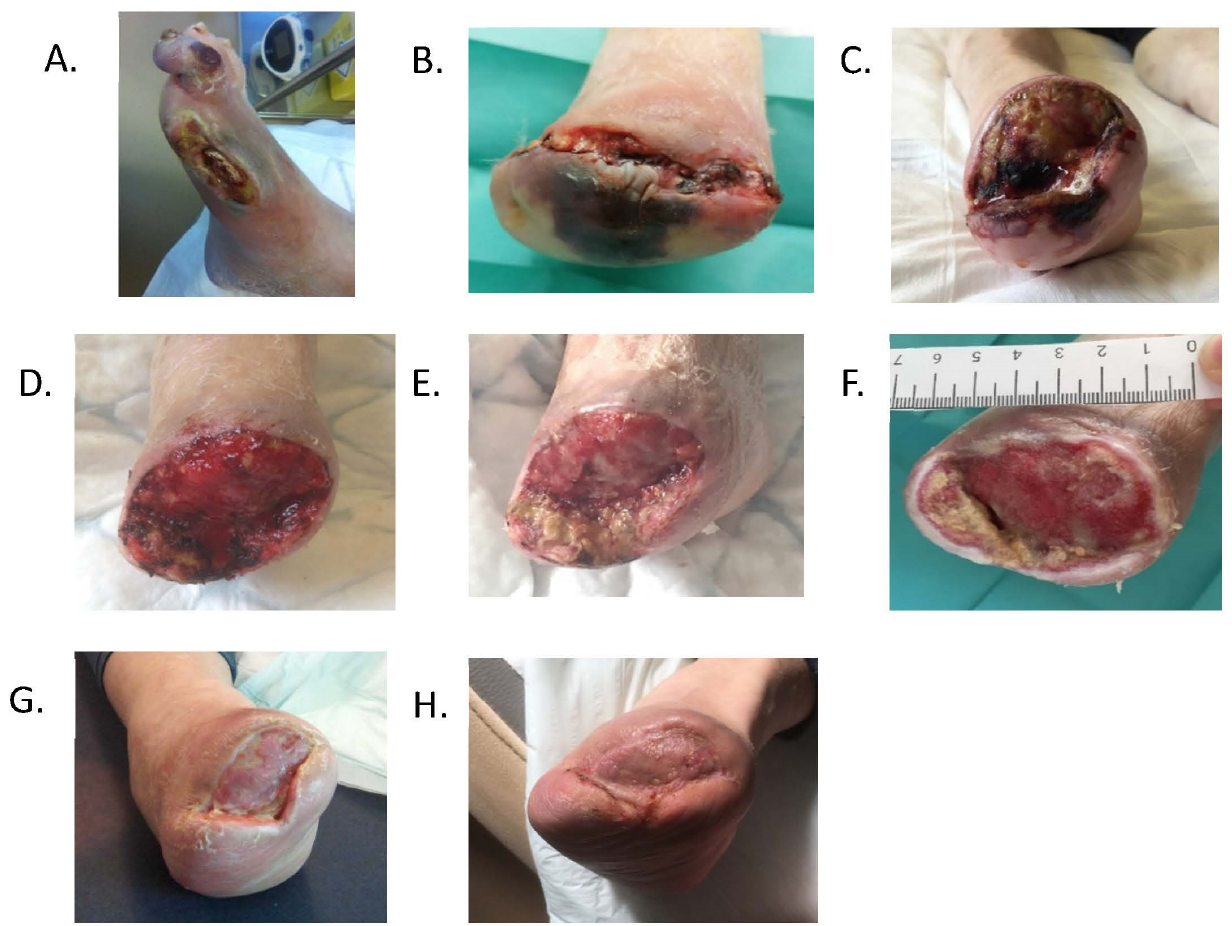
Figure 2. Wound management following diabetic foot ulcer-related amputation. ( A ) Four months after first ray amputation; ( B ) one day after transmetatarsal amputation; ( C ) upon admission to the diabetic foot unit one week after Lisfranc amputation (26 January 2021); ( D ) three days after applying the wound environment control system Vistacare ® ; ( E ) two weeks of treatment using Vistacare ® ; ( F ) before skin graft; ( G ) six weeks after skin graft; ( H ) three months after skin graft.